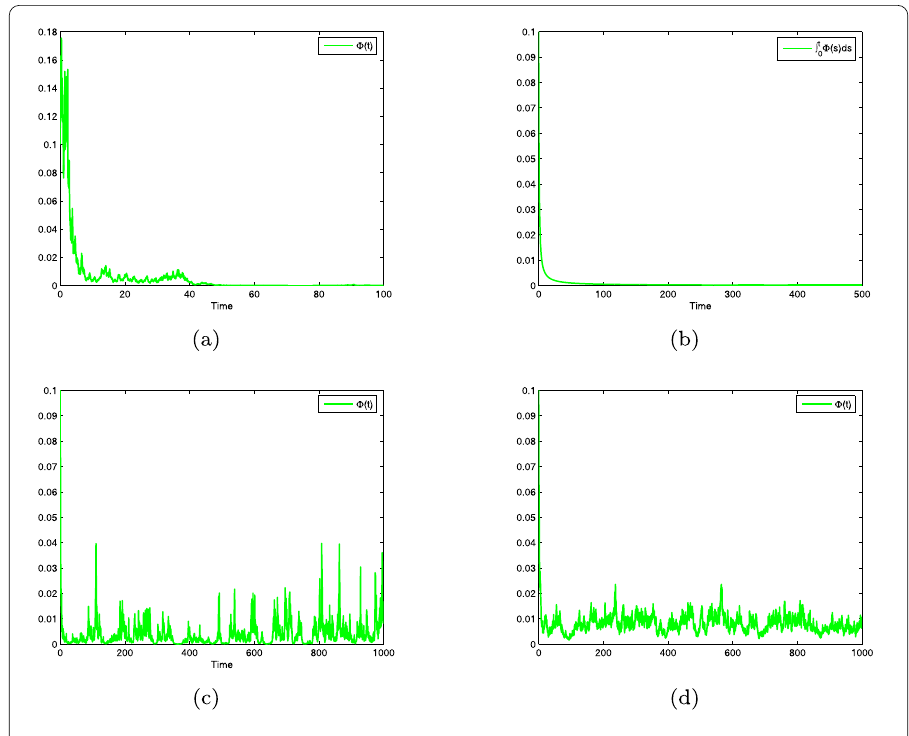
β 2 1 = 0.3, which reflects